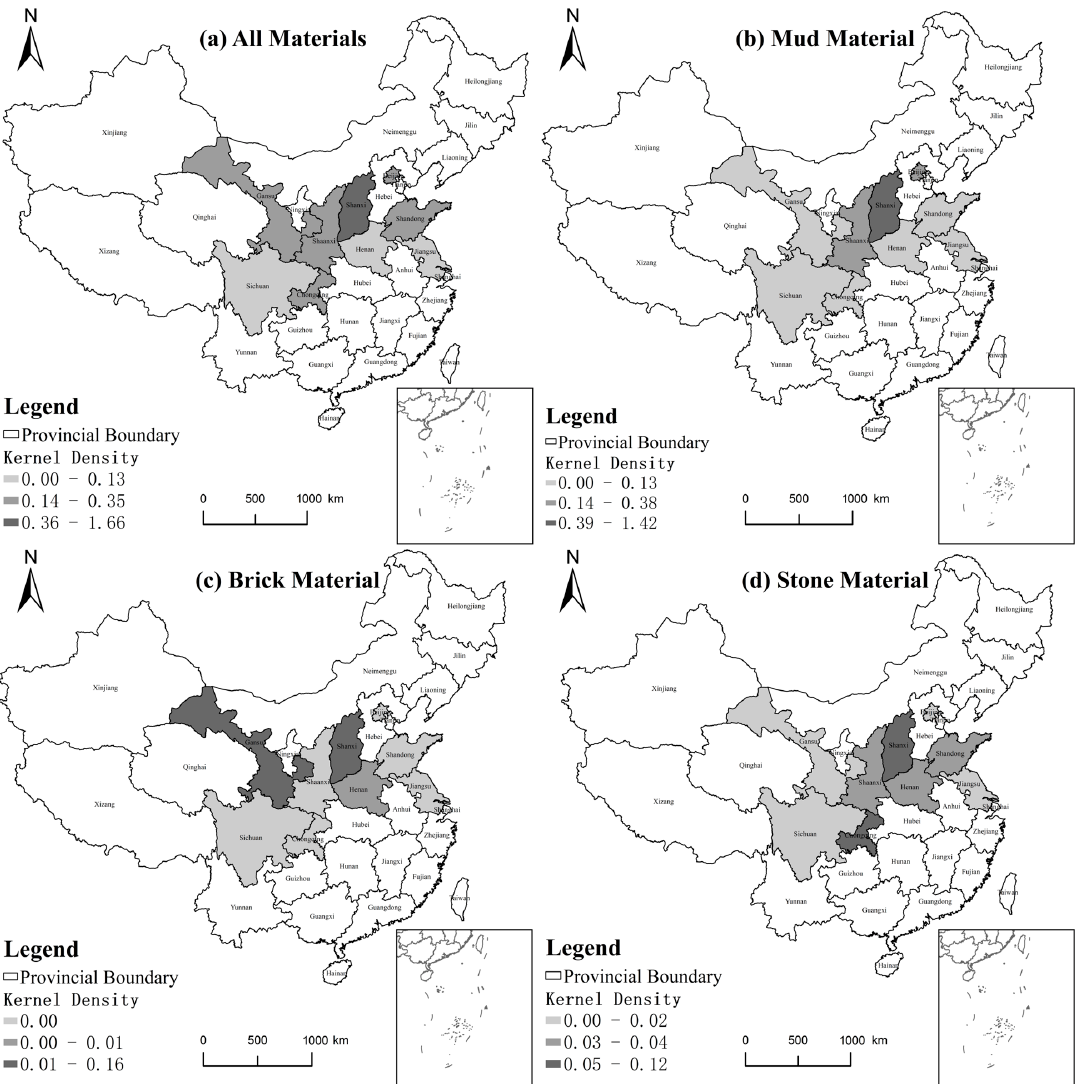
Figure 9. Distribution map of the kernel density of the types of relic sites in the Yuan Dynasty. Additionally, a comparison of the correlations of the secondary-level distribution map indicates that the high-density mud material region (Figure 9b) entirely coincided with the high-density region (Figure 9a) for the overall type map of the same period, in- dicating that mud material was mainstream during this period. Moreover, brick and stone materials were distributed in other high-density regions. The former includes Gansu, as shown in the high-density brick material regions in the Wei, Jin, Southern, and Northern